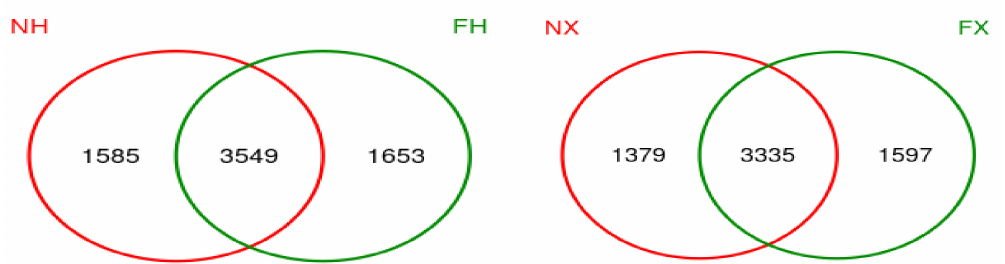
Figure 6. The Venn diagram of bacteria in the colostrum and feces samples of the same dairy farm. Note: NX ( n = 16) and NH ( n = 18) represent colostrum samples from dairy farm X and dairy farm H, FX ( n = 16) and FH ( n = 19) represent rectal feces samples from dairy farm X and dairy farm H.